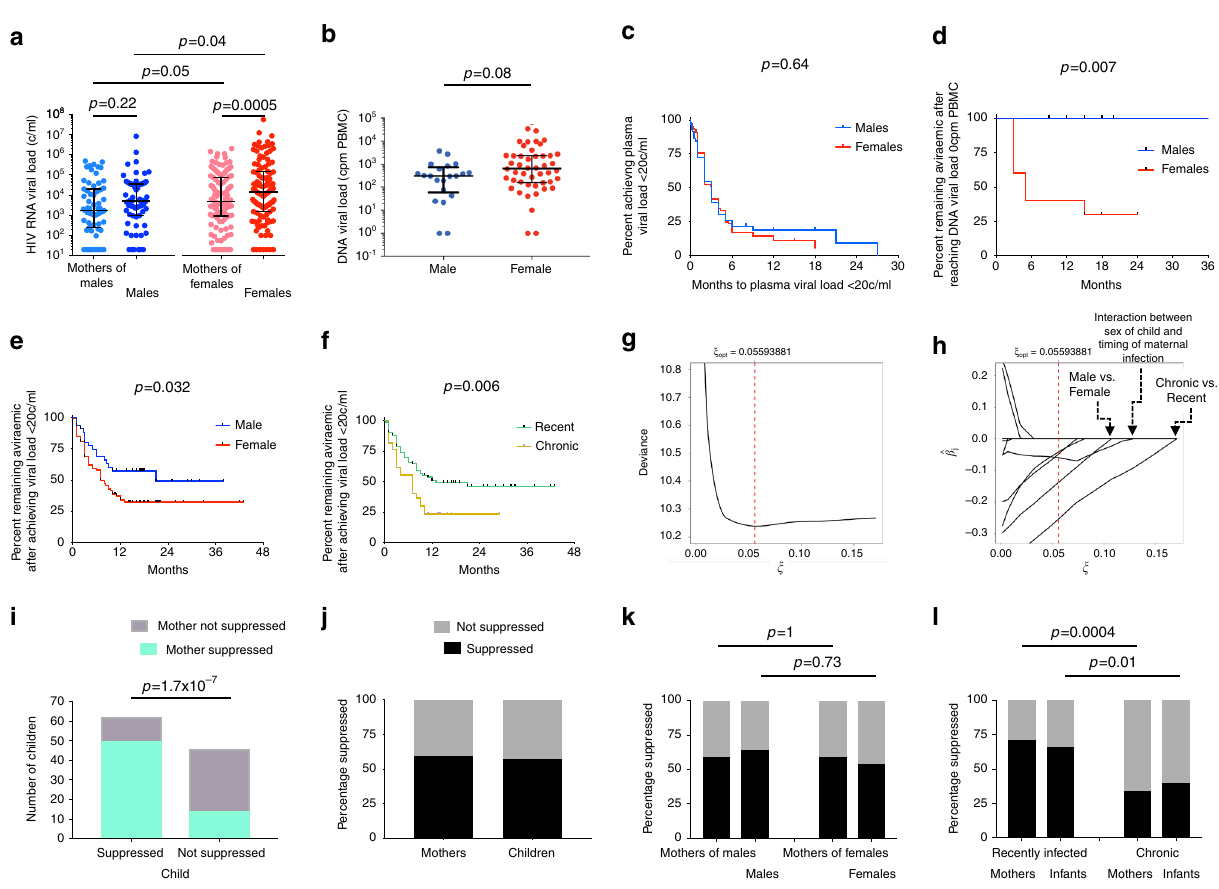
Fig. 3 Impact of sex differences and timing of maternal infection on outcome post-infection on plasma RNA and DNA viral loads, and viral rebound on ART. a Baseline plasma RNA viral loads in 177 mother-child pairs. The statistical tests used were the Mann – Whitney test (comparing males versus females and comparing mothers of males versus mothers of females) and the Wilcoxon matched-pairs signed rank test (comparing males versus mothers of males and comparing females versus mothers of females). In each case, p values were 2-sided. Medians and interquartile ranges are shown. b Baseline total DNA viral loads in 69 in utero-infected infants (48 female, 21 male). The statistical test used was the Mann – Whitney test, the p value was 2-sided. c – f Kaplan – Meier curves showing time to achieve plasma HIV RNA load of <20 copies/ml in males and females (panel c ), time to viral rebound (>20 copies/ ml) in males and females (panels d , e ), time to viral rebound (>20 copies/ml) in in utero-infected children born to recently and chronically infected mothers (panel f ). In panel D, data are shown from the 17 subjects who reached DNA viral loads reported as 0 cpm PBMC. In each case, the statistical tests used were the Log-rank (Mantel – Cox) test. g The cross-validation error for a grid of LASSO penalty parameters ξ in order to determine the optimal amount of penalisation. h The coef fi cient paths of the (standardised) regression parameter estimates versus the LASSO penalty parameter ξ ; the optimal ξ is indicated by the vertical red dashed line. Re-standardised coef fi cients of the coef fi cients selected by the model were: Recent maternal infection: − 0.552; Interaction between infant sex and timing of maternal infection: − 0.146; Male sex of infant: − 0.101; Age of infant at baseline: − 0.023; plasma RNA viral load at baseline: 7.4 × 10 − 9 . Parameters not selected were: infant baseline absolute CD4 count, CD4%, absolute CD8 count, CD8%, and CD4:CD8 ratio. i – l . Suppression of viraemia (plasma viral load <20 copies/ml) in mother-child pairs using most recent timepoint studied. Panels i – j : all mother child pairs studied (n = 108); panel k : mothers of males and males (39 pairs) compared with mothers of females and females (69 pairs); panel l : recently infected mothers and children (73 pairs) compared with chronically infected mothers and children (35 pairs). In panels i – l , the statistical tests used was Fisher ’ s Exact test; p values were 2-sided. Source data are provided as a Source Data fi